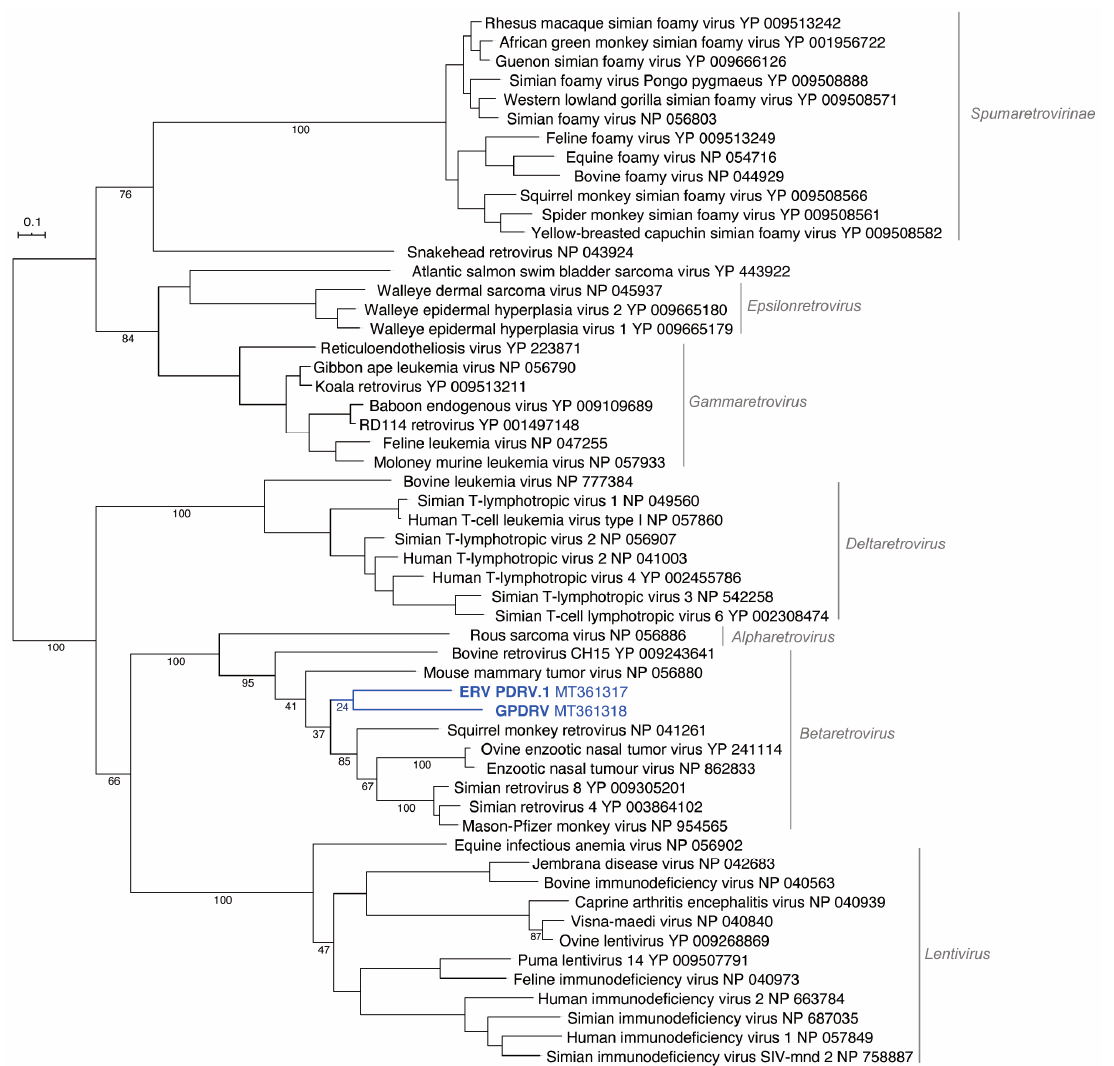
Figure 4. GPDRV is a betaretrovirus . All Pol sequences in the NCBI RefSeq protein database annotated as belonging to the Retroviridae family longer than 600 amino acids were used to infer a maximum-likelihood tree. The Felsenstein bootstrap (FBP) support values of select branches are indicated. Retrovirus genera and subfamilies (except for Spumaretrovirinae ) are indicated. The tree is unrooted and was arbitrary midpoint rooted.